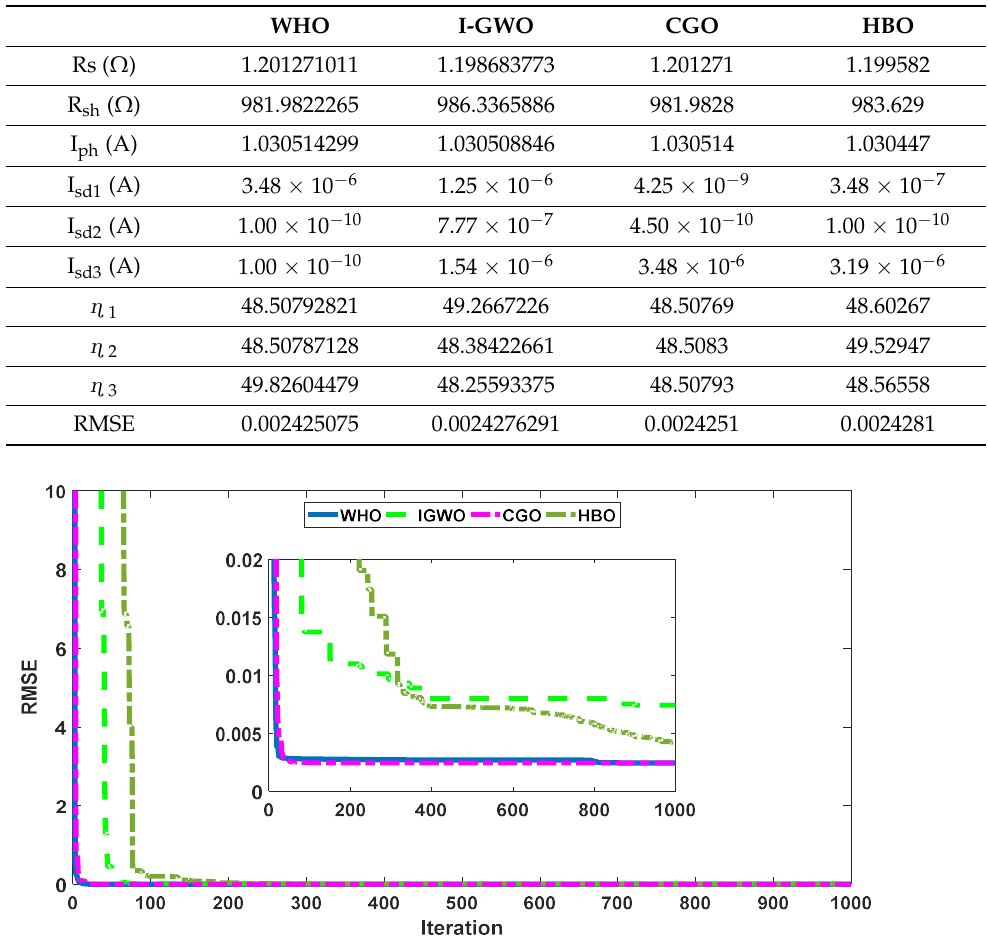
Table 5. RMSE and estimated parameters for all compared algorithms.